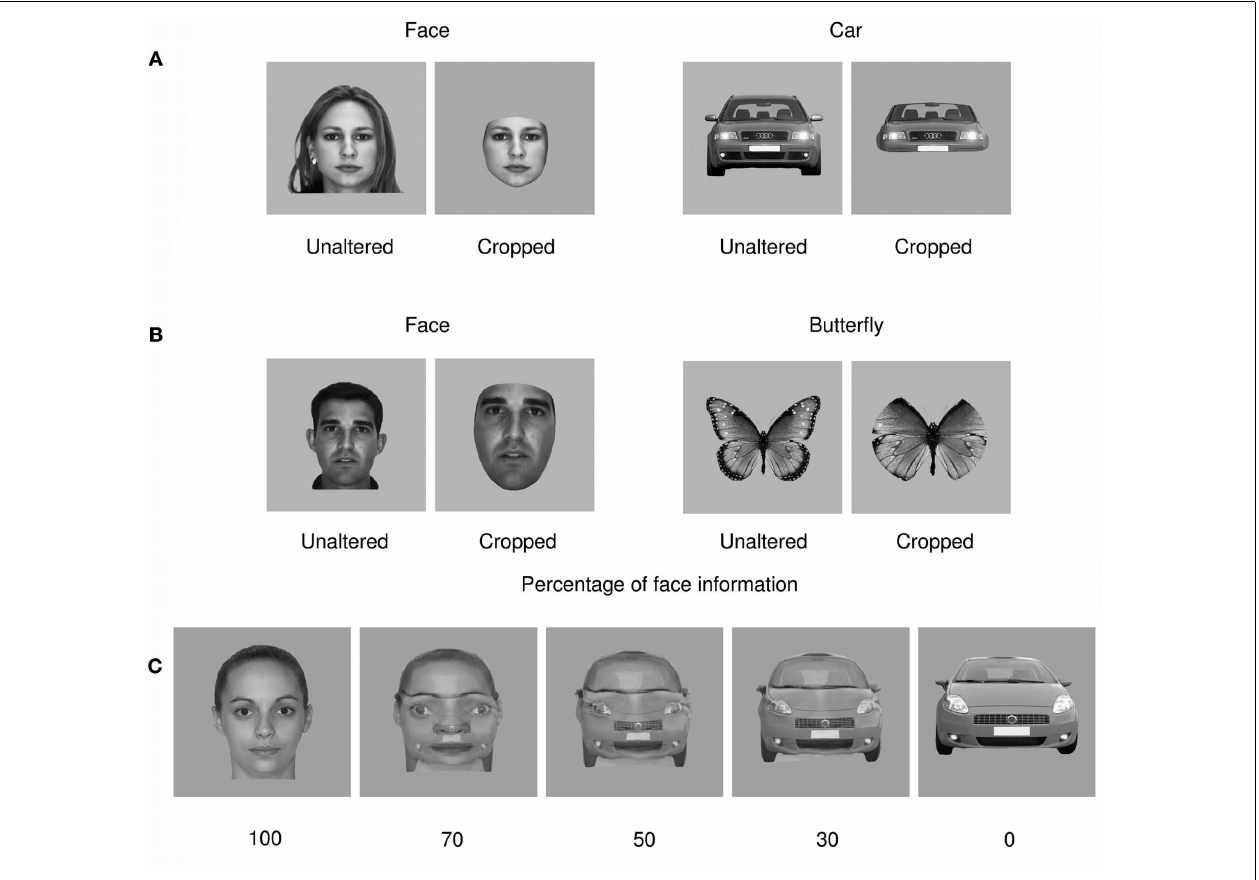
unaltered faces and butterflies after matching for luminance, contrast, and size. (C) Examples of progressive morphing between a face and a car stimulus. Note that 50% face–50% car morphs were used as target stimuli and not